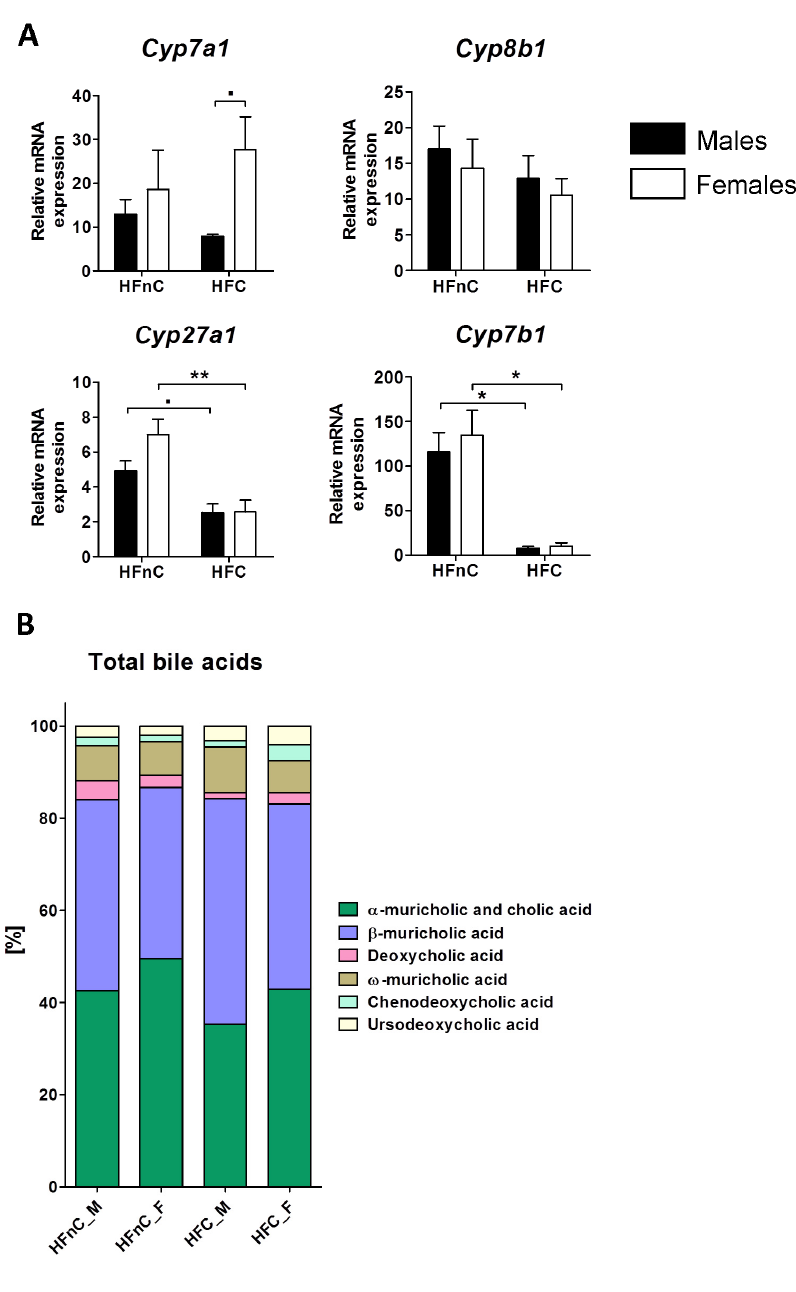
Figure 5. Expression of bile acid synthesis genes (A) in the liver and gallbladder bile acid composition (B). Black columns represent male and white columns female mice. Error bars represent SEMs. N = 8; ˙ p < 0.1; * p < 0.05; ** p < 0.01; *** p <